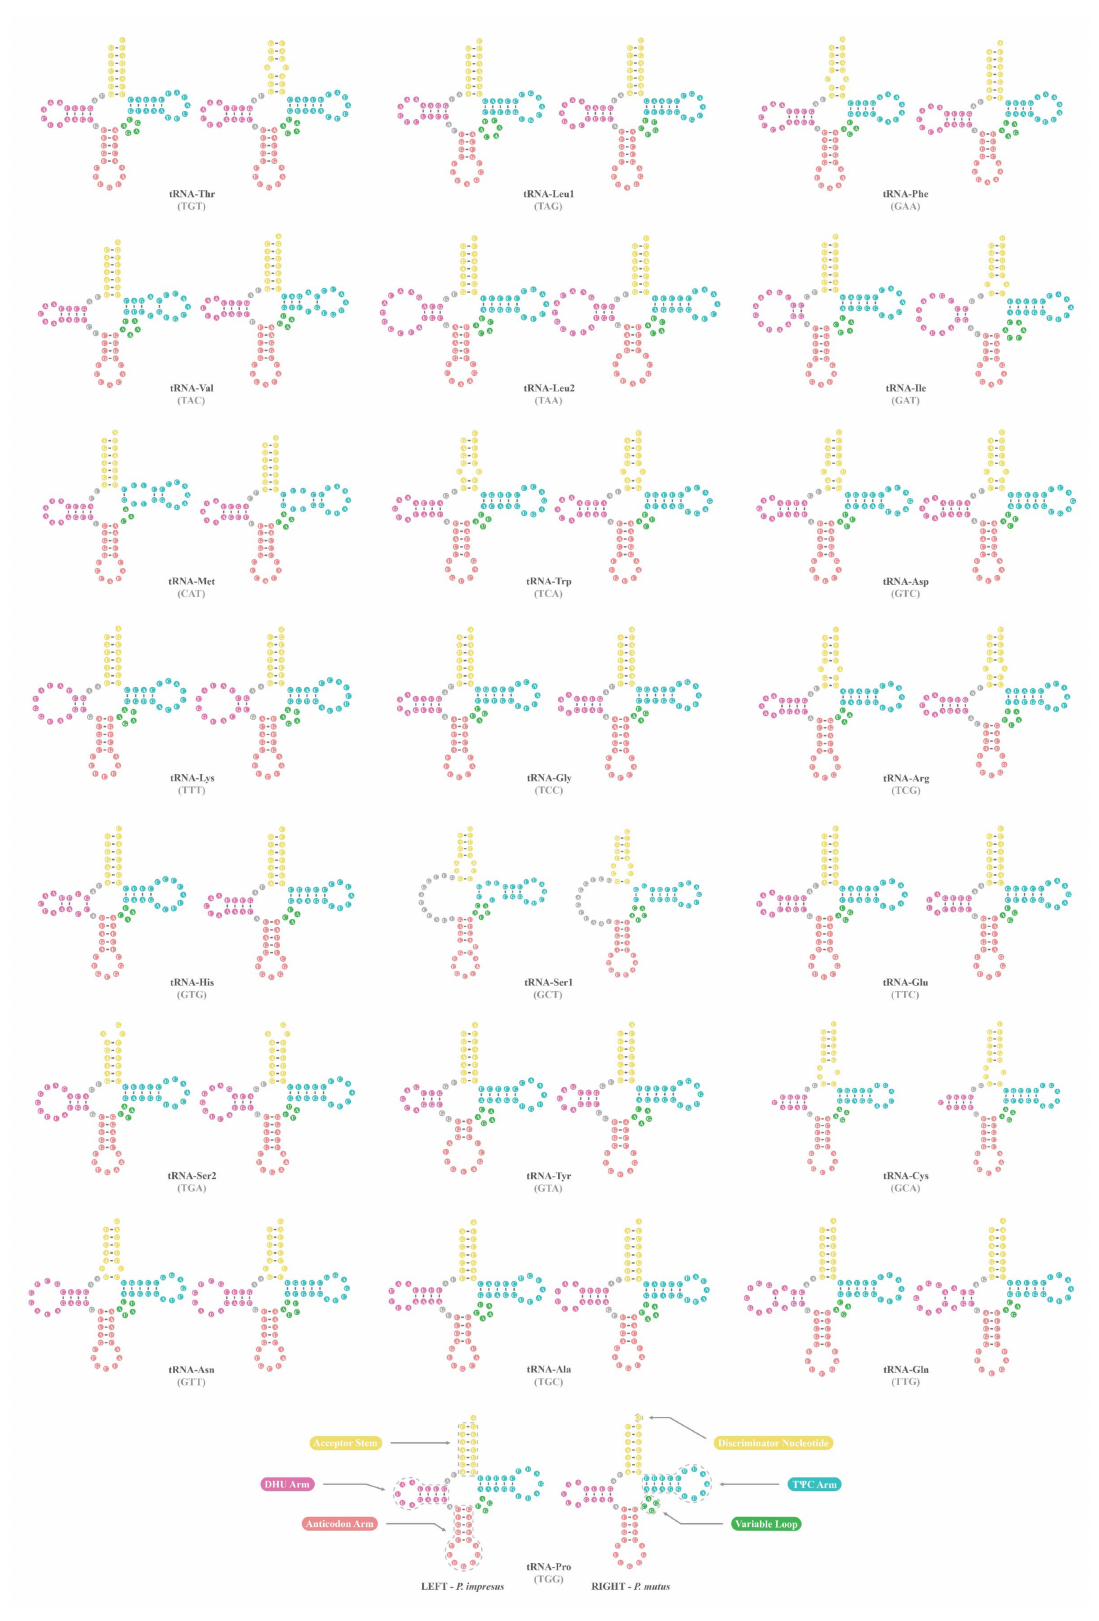
Figure 3. Putative secondary structures for 22 tRNA genes in the mitogenome of Polypedates impresus (left) and Polypedates mutus